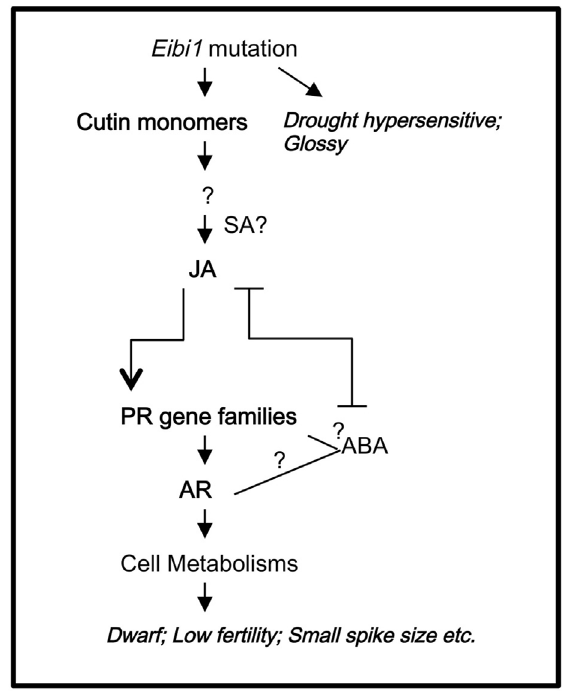
Figure 6 - Possible acquired resistance (AR) pathway of eibi1